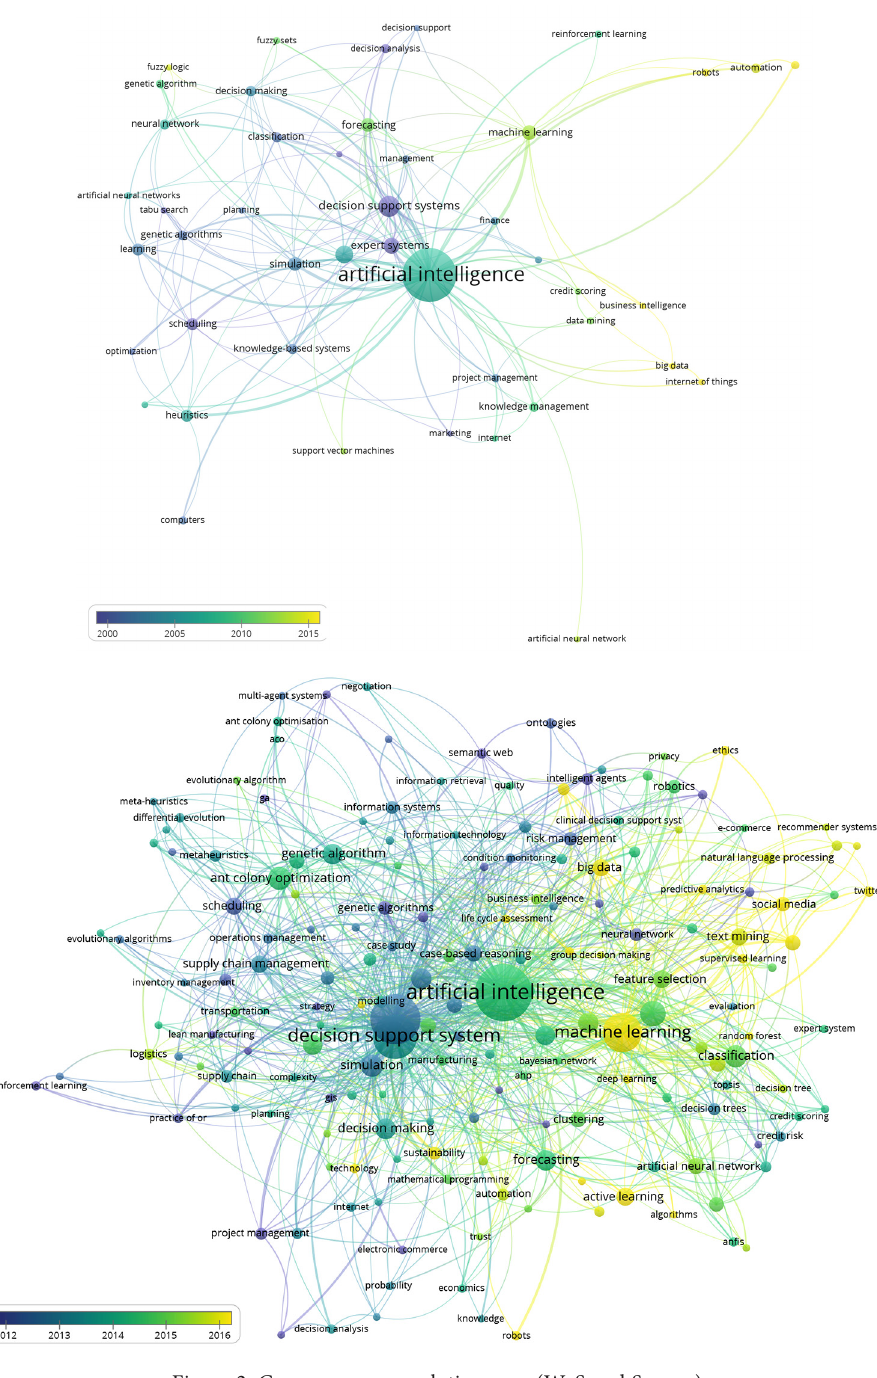
Figure 2. Co-occurrence evolution map (WoS and